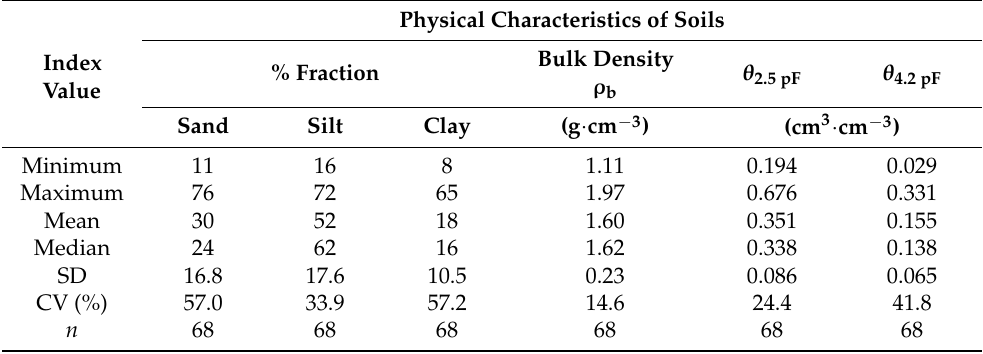
Table 4. Basic descriptive statistics for soil physical properties over all depths ( n =